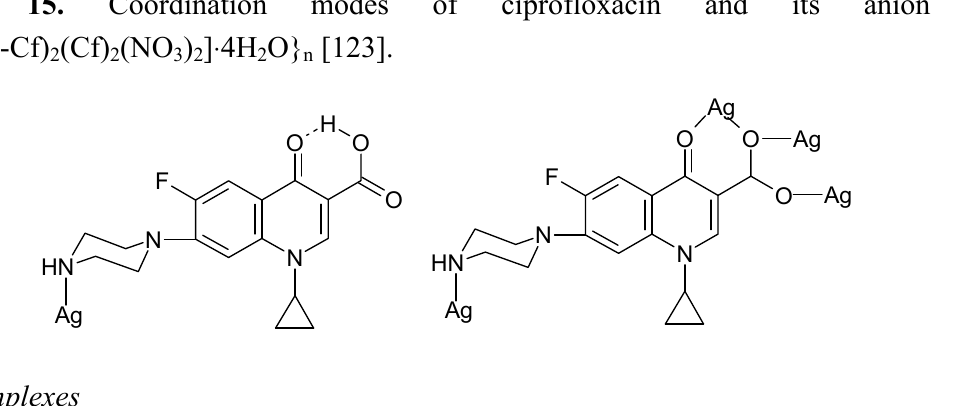
pseudo-tetranuclear building blocks are constructed via unidentate ciprofloxacin coordinated through the N4 piperazine atom and tetradentate deprotonated ciprofloxacin ligands (Figure 15). Figure 15. Coordination modes of ciprofloxacin and its anion